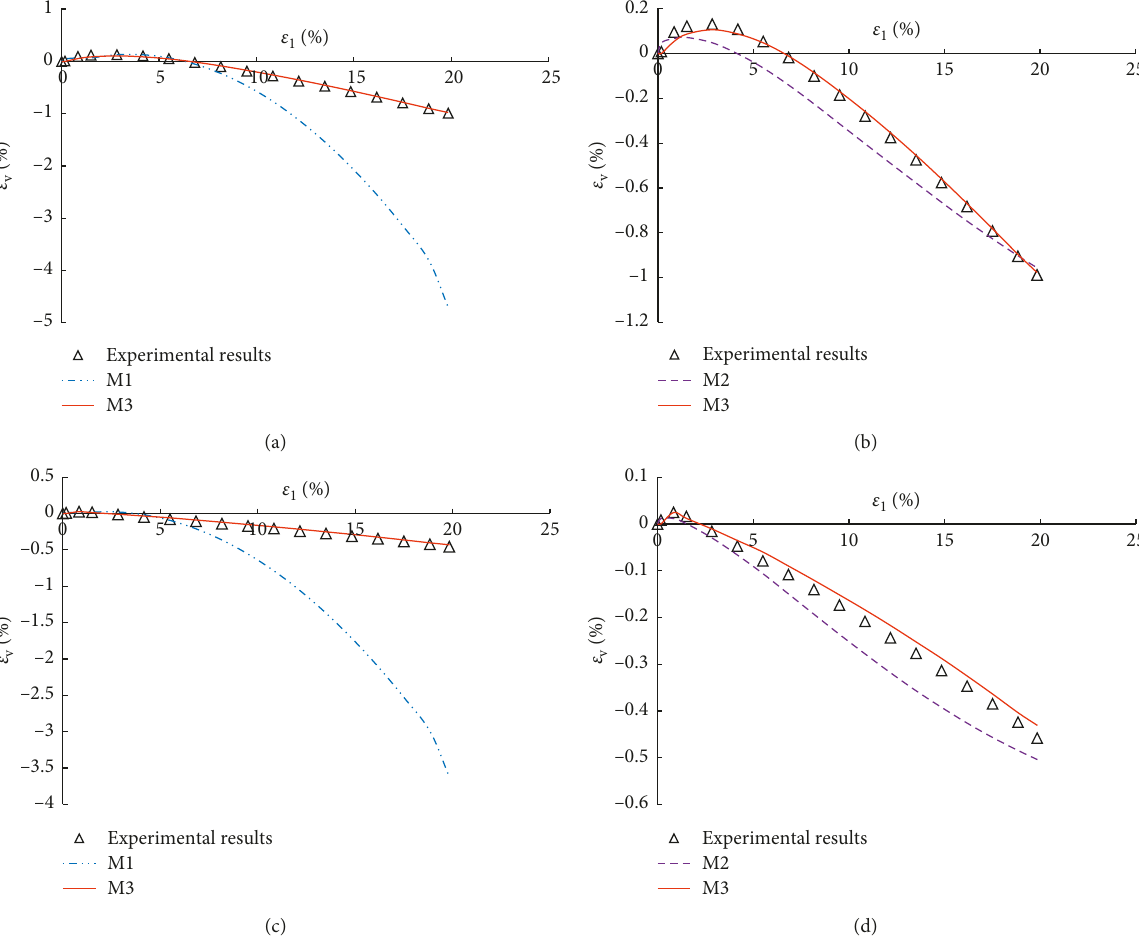
Figure 12: Volumetric strain-axial strain relationship fitting results for each model at − 5 ° C. Comparison between experimental results and calculated results of (a) M1 and M3 ( T � − 5 ° C, σ 3 � 1.0 MPa), (b) M2 and M3 ( T � − 5 ° C, σ 3 � 1.0 MPa), (c) M1 and M3 ( T � − 5 ° C, σ 3 � 8.0MPa), and (d) M2 and M3 ( T � − 5 ° C, σ 3 �